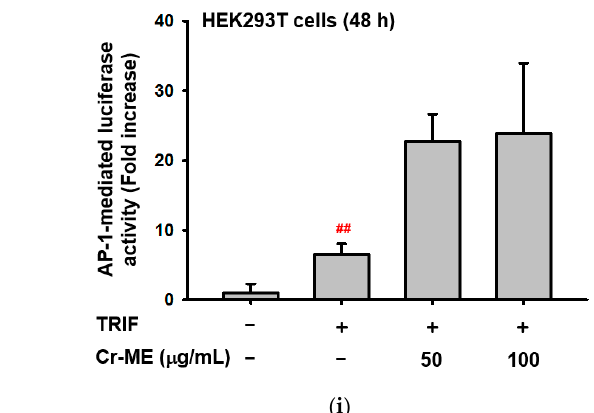
Figure 2. Suppressive effect of Cr-ME on the mRNA expression of inflammatory genes and their transcriptional activation. ( a , b ) The mRNA levels of inflammatory genes from RAW264.7 cells-stimulated with LPS (1 μ g/mL) for 6 h in the presence or absence of Cr-ME (5 to 200 μ g/mL) were measured by semi-quantitative RT-PCR ( a ) and relative band intensity of inflammatory genes was quantified using ImageJ software ( b ). ( c , d , f , h , i ) Effect of Cr-ME on transcription factor activation was determined by luciferase assay. HEK293T cells overexpressed with FLAG-MyD88 ( c ), CFP-TRIF ( d , h , i ) or FLAG- TBK1 ( f ) were transfected with plasmid constructs of NF- κ B-Luc ( c , d ), PRD (III-I)-Luc ( f , h ), AP-1-Luc ( i ), and β -gal (as a transfection control) for 24 h, followed by treatment with Cr-ME (50–100 μ g/mL) for additional 24 h. Luciferase activity was measured using a luminometer and normalized to that of β -gal. ( e , g ) Levels of p65, p50, Flag, IRF3, and lamin A/C in the nuclear fraction of HEK293T cells co-transfected with MyD88 ( e ) or TBK1 ( g ) were determined by Western blotting analysis. All the data ( b – d , f , h , i ) are expressed as the mean ± SD of three independent experiments. Relative band intensity ( b ) was measured using ImageJ. Statistical significance was calculated using one-way ANOVA ( Dunnett’s t -test ). # p < 0.05, ## p < 0.01, ### p < 0.001, and #### p < 0.0001 compared with the normal group, *** p <0.001 and **** p < 0.0001 compared to the LPS group, * p < 0.05 and ** p < 0.01 compared to control group.